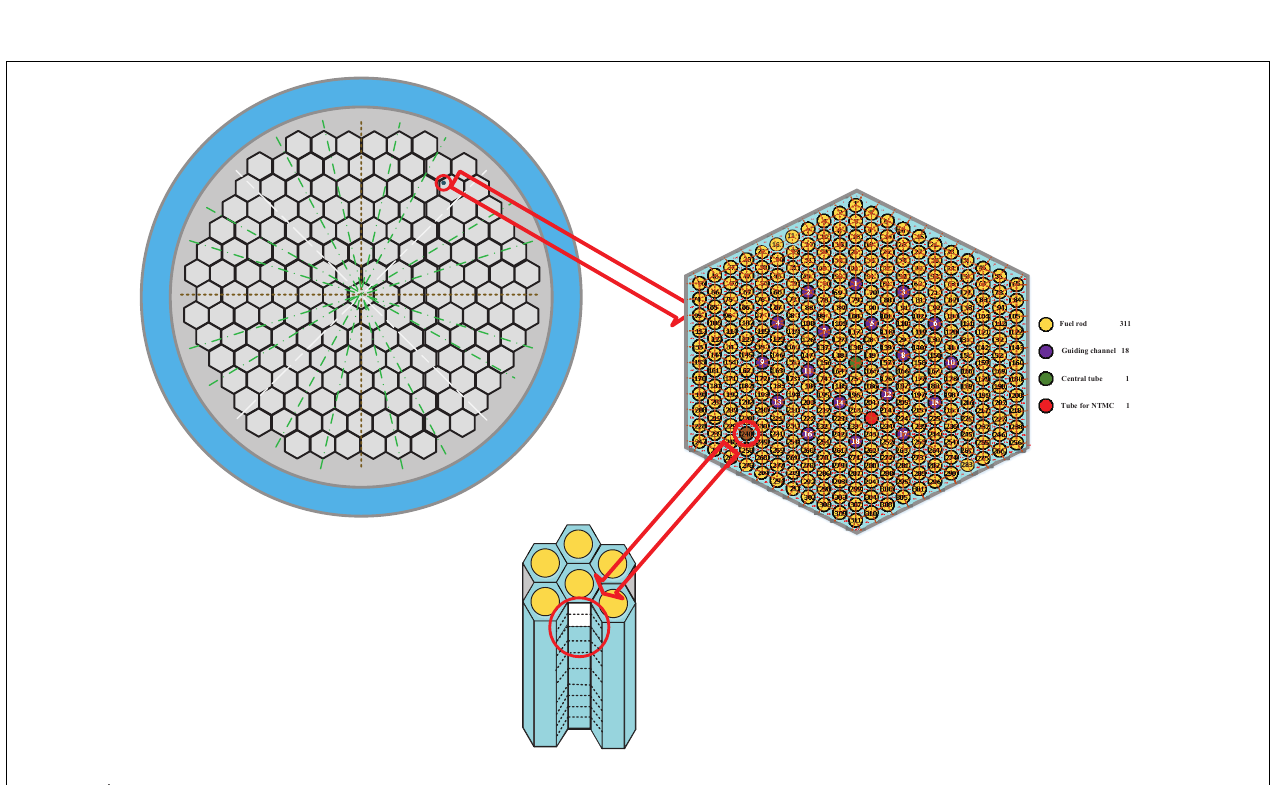
FIGURE 4 | Local blockage accident